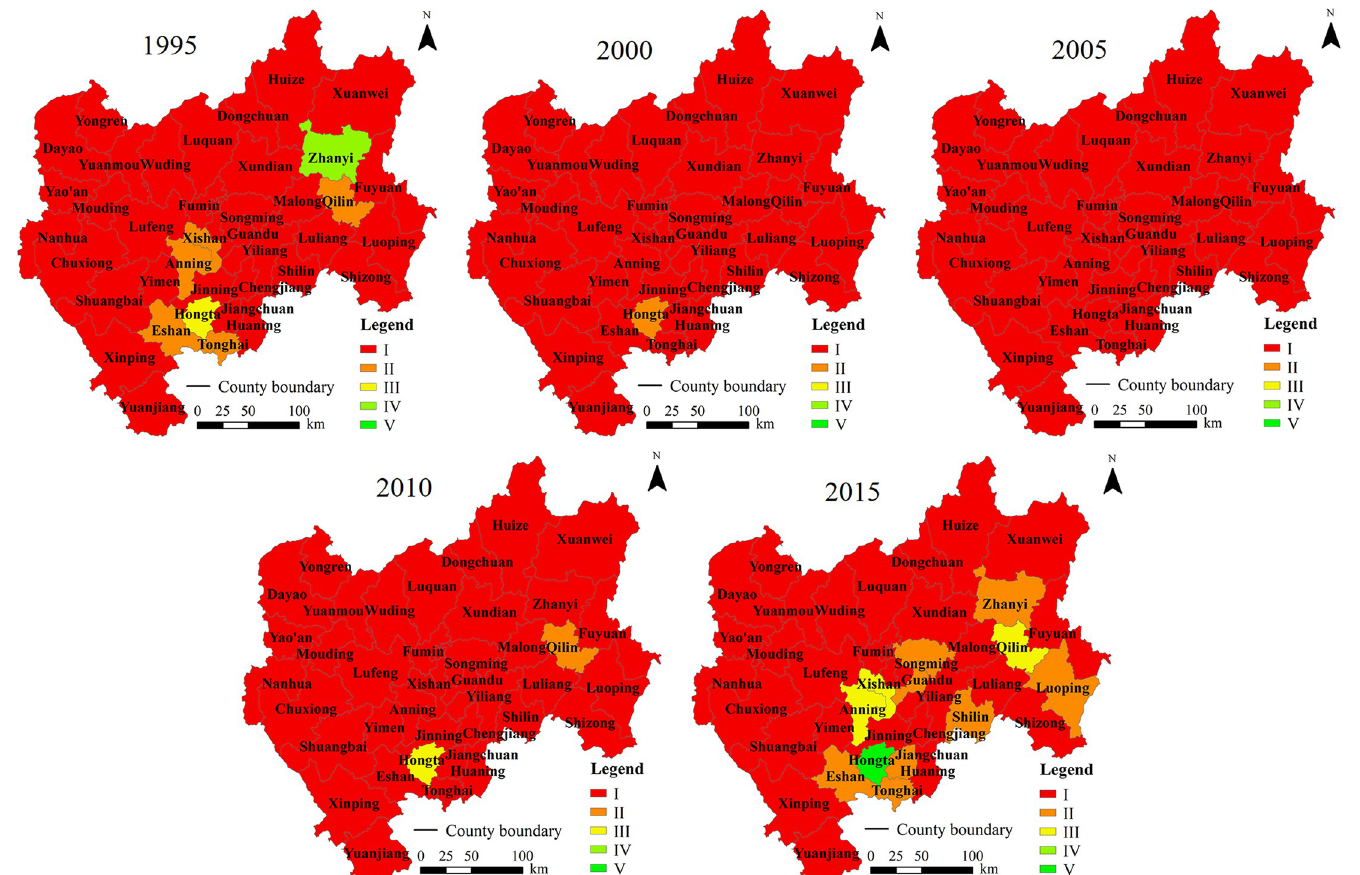
Fig 5. Distribution of ecological security levels in CYP at the county